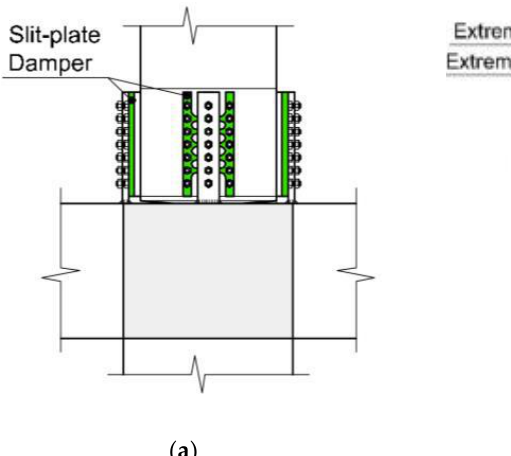
Figure 3. Stainless-steel slit-plate damper.